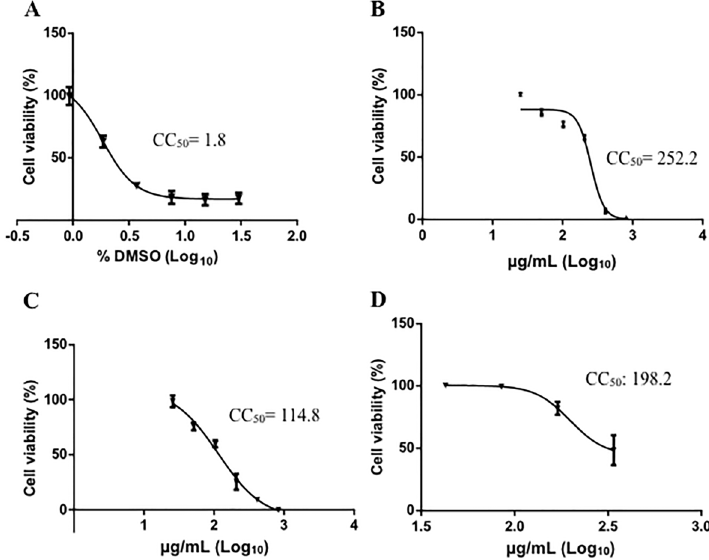
Figure 4. Cytotoxicity of the saponins and DMSO. Vero E6 cells grown in a 24-well plate were treated with 2-fold serial dilutions of DMSO ( A ) and saponins S1 ( B ), S2 ( C ), and S3 ( D ) and then incubated for 7 days. Cell viability was evaluated by MTT assay. The cytotoxic concentration (CC 50 ) values of DMSO and saponins were determined by nonlinear regression analysis. The data are reported as means ± SE of quadruplicate